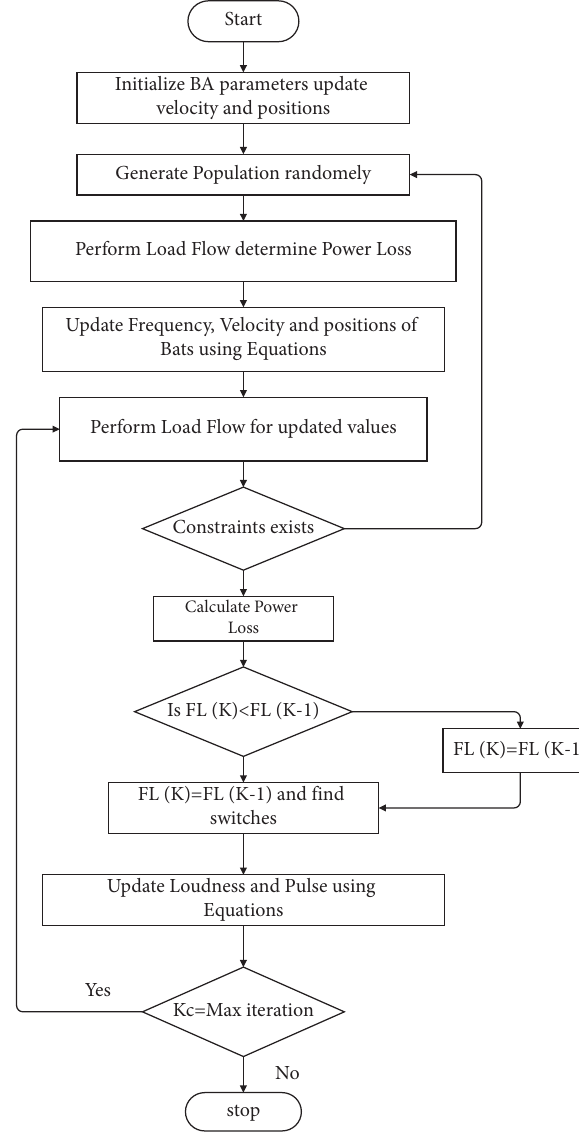
Figure 5: Bat algorithm